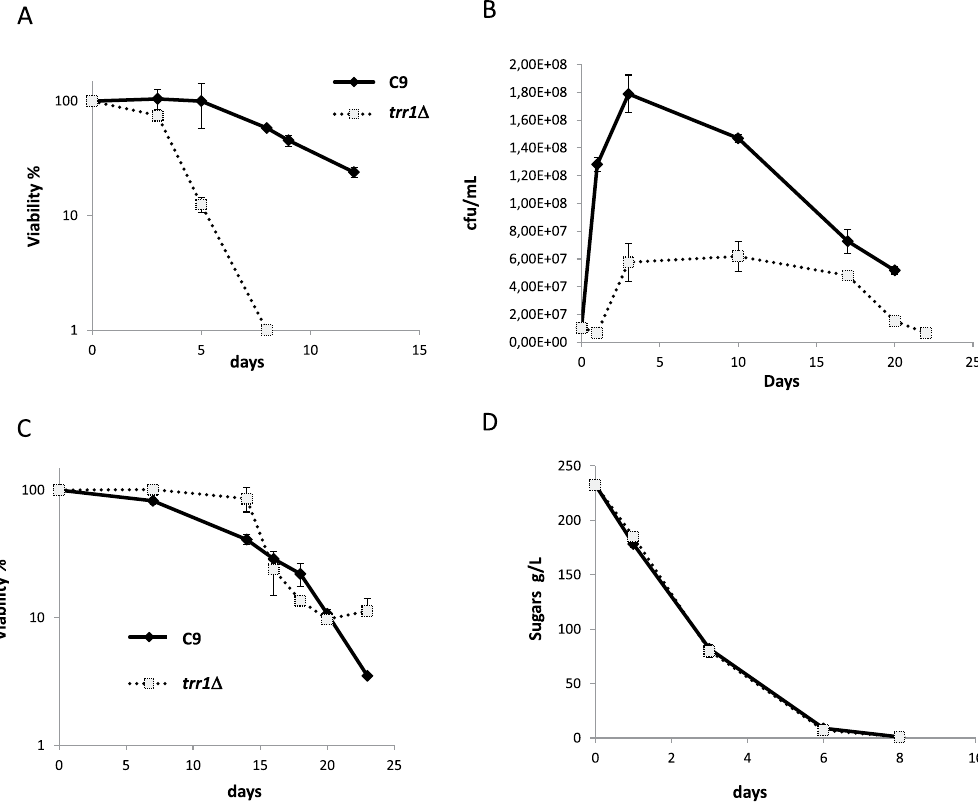
Figure 1. TRR1 deletion impacts growth and longevity. ( A ) A standard chronological life span analysis in SC medium of wine yeast C9 and its trr1 Δ derivative. ( B ) Viable cell number in the natural grape juice fermentations of the C9 wine strain and the trr1 Δ deletion mutant. ( C ) Survival curve along the aforementioned vinifications. The viable cell number on day 3 from Panel (B) was taken as 100% survival. ( D ) Sugar consumption during grape juice fermentations described in panel (B). Experiments were done in triplicate. The mean and standard deviation are